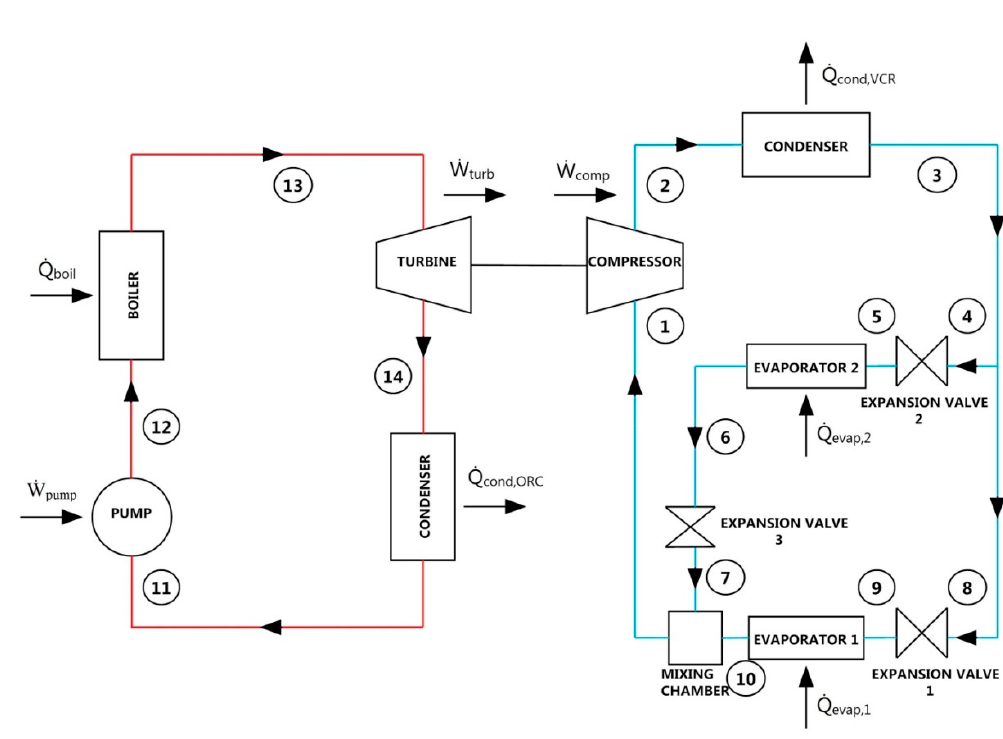
Figure 2. Schematic of combined ORC-dual evaporator VCR cycle.